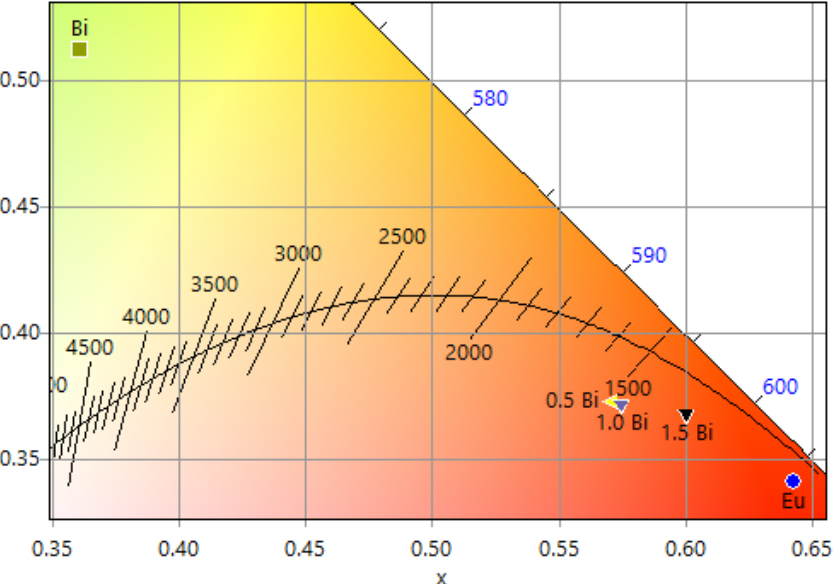
Figure 12. CIE chromaticity coordinates for the LuVO 4 : 2.5 at. % Eu 3+ , X at. % Bi 3+ (X = 0.5, 1, 1.5) films and a Bi 3+ mono-doped sample.